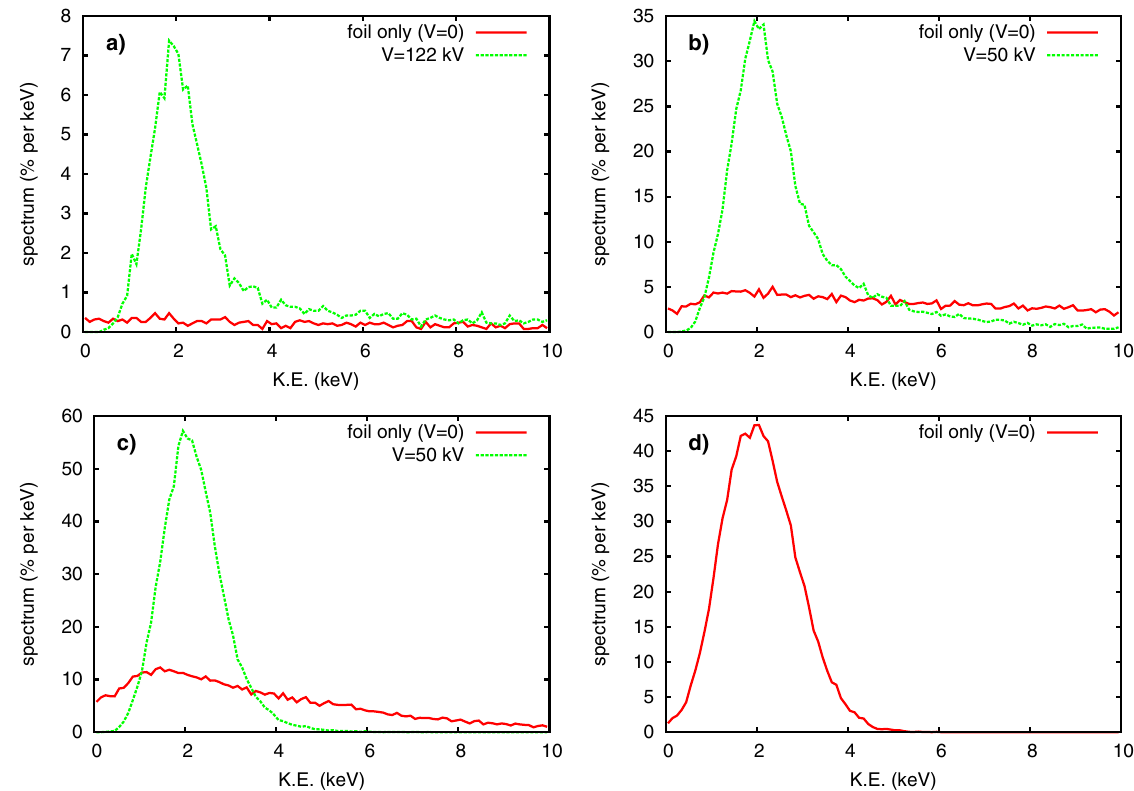
FIG. 7. Antiproton spectrum for (cid:10) (cid:9) ¼ 0 : 1 with or without frictional cooling, from the various configurations: (a) antiprotons straight from the AD, or further deceleration from (b) induction linac, (c) RFQ, or (d)